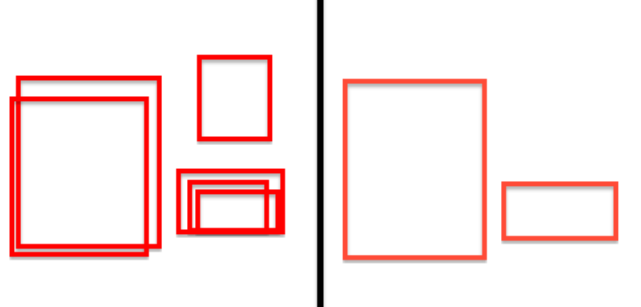
Figure 8. Sample of how the partitioning and grouping algorithms cleans up multiple overlapping detection